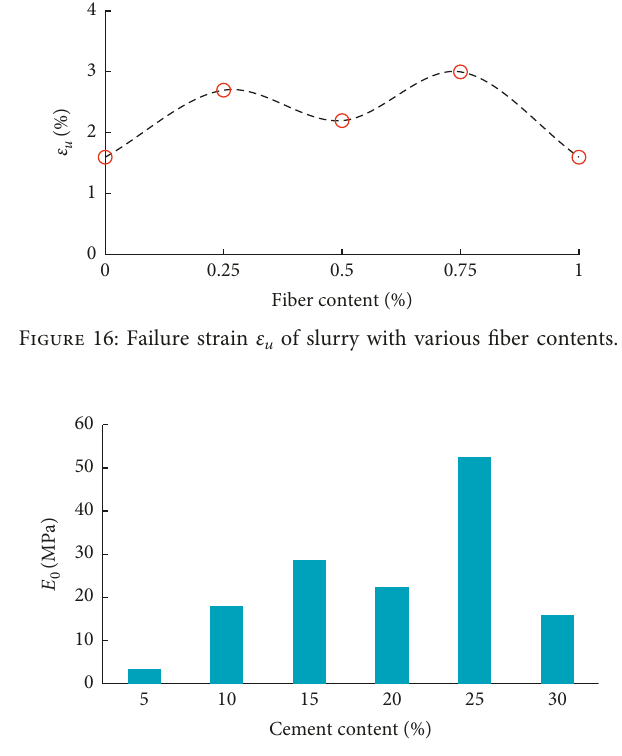
Figure 17: Initial elastic modulus E